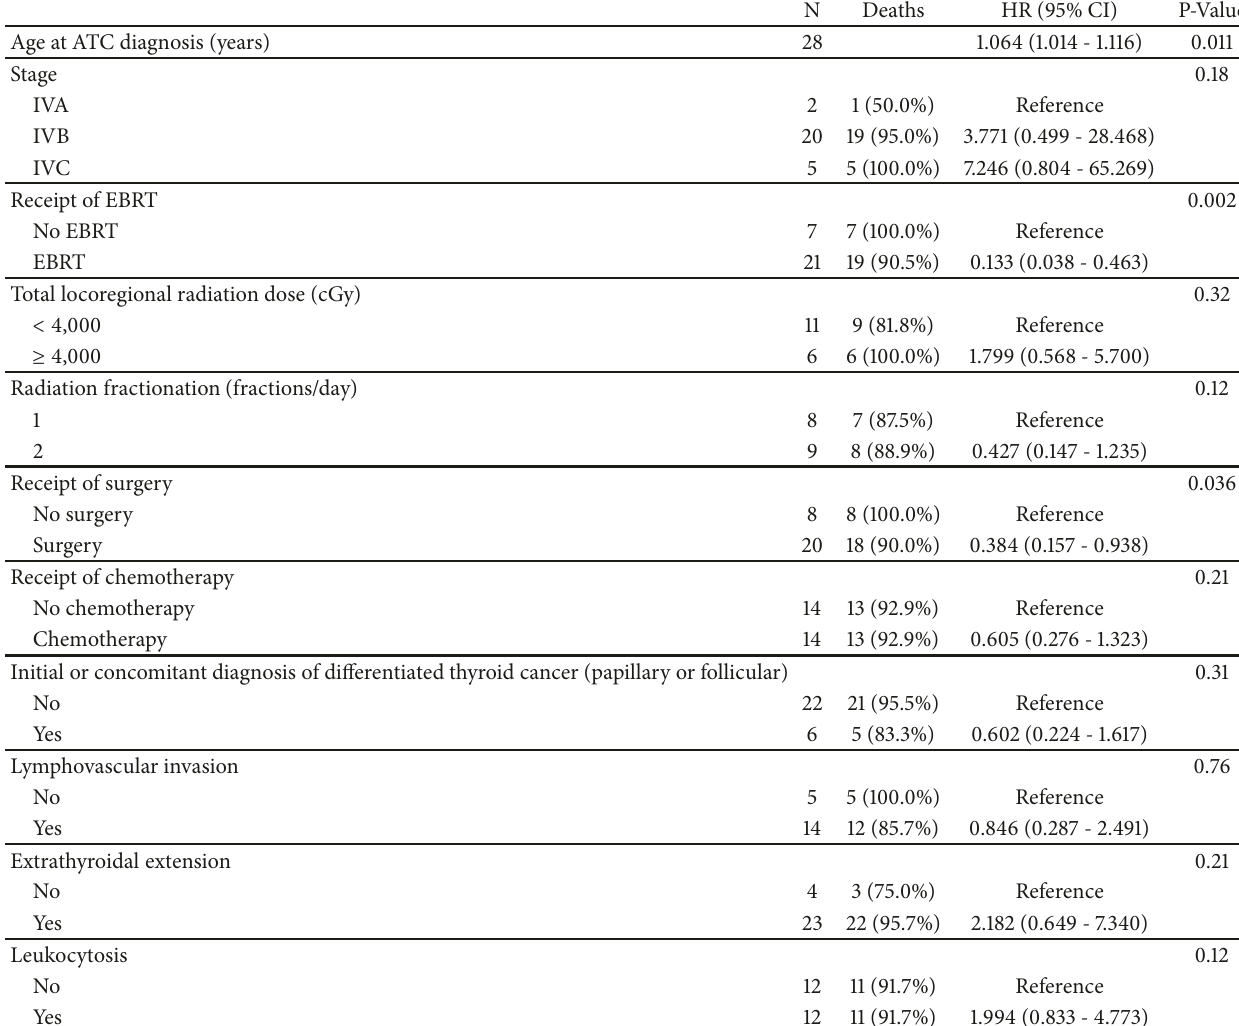
Table 3: Univariate overall survival analysis (N=28, # events=26, 7% censored).